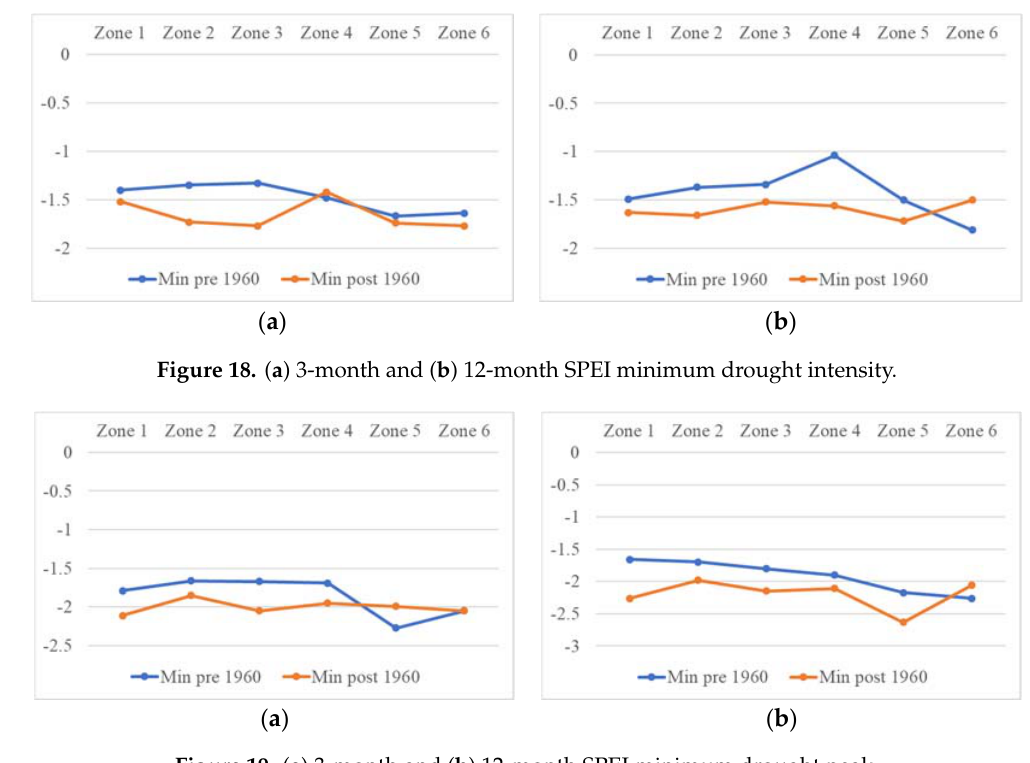
Figure 19. ( a ) 3 ‐ month and ( b ) 12 ‐ month SPEI minimum drought peak. Figure 19. ( a ) 3-month and ( b ) 12-month SPEI minimum drought